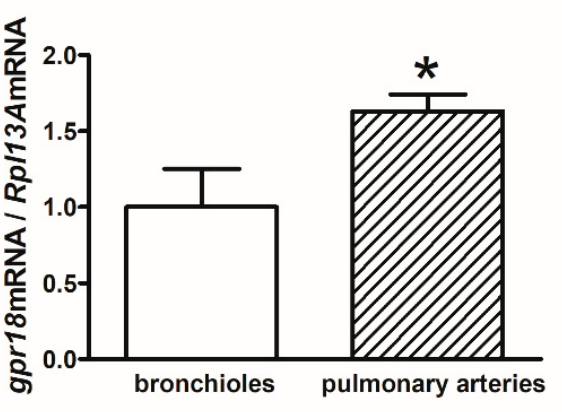
lobectomy (5), left pneumonectomy (1) IA (7), IB (2), IIA (4), IIB (10), IIIA (4) α 1 -Adrenoceptor antagonist (3), ACE inhibitors (8), β blockers (7), statins (9), calcium channel blocker (4), potassium channel blocker (1), diuretics (5), hypoglycemic medication (4), anticoagulants (4), protein pump inhibitors (1) Values of pEC 50 and R max for vasodilatory effects of PSB-MZ-1415 and NAGly are based on the concentration- response curves in Figure 4 and represent mean percentage relaxations of the isometric contraction induced by U46619 and with the standard error of the mean (SEM) fit to non-linear regression (curve fit). N, number of all patients; n , the number of patients selected for the respective studies with PSB-MZ-1415 and NAGly. * p < 0.05; ** p < 0.01; compared to male, non-smokers and normocholesterolemic patients, respectively, as determined by Student’s t -test for unpaired data. ACE, angiotensin-converting enzyme; BMI, body mass index; pTNM classification (VIIIth edition).